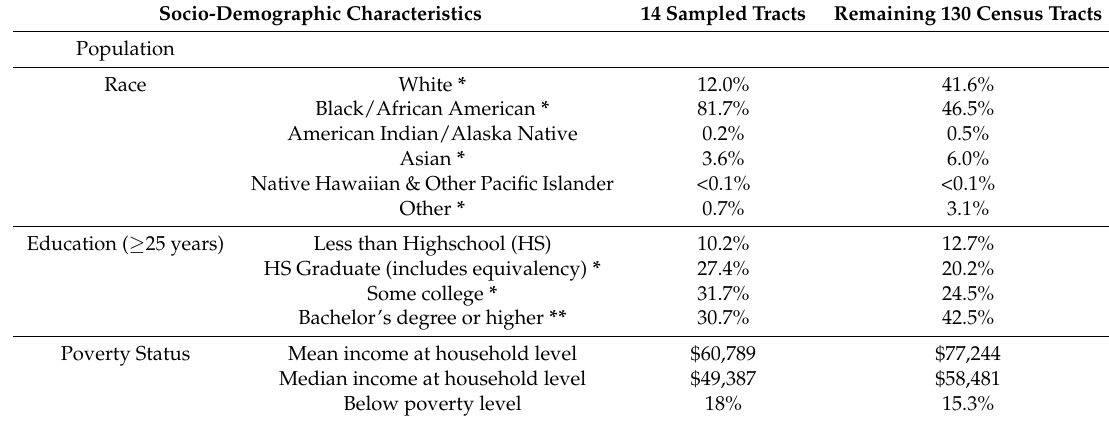
Table 1. American Community Survey data comparing the 14 selected tracts to the rest of DeKalb